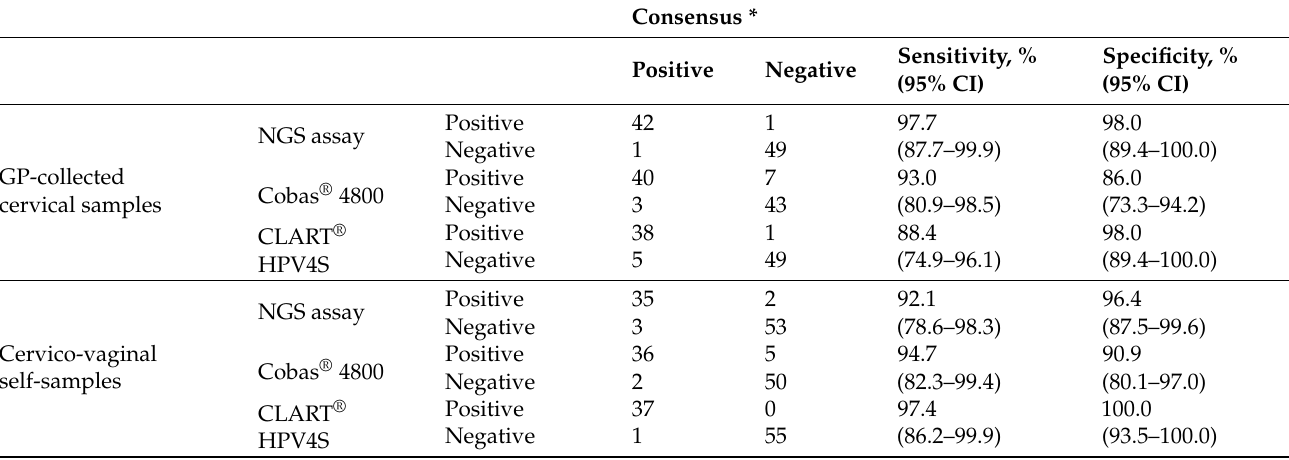
Table 2. Sensitivity and specificity for detection of any 1 HPV type in the NGS assay, Cobas ® 4800, and CLART ® HPV4S on GP-collected cervical samples and cervico-vaginal self-samples using a consensus * as